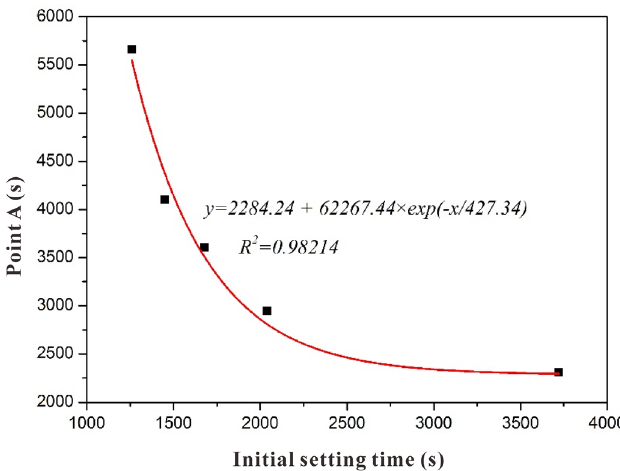
Figure 12. Relationship between characteristic point A of the resistivity and initial setting time.